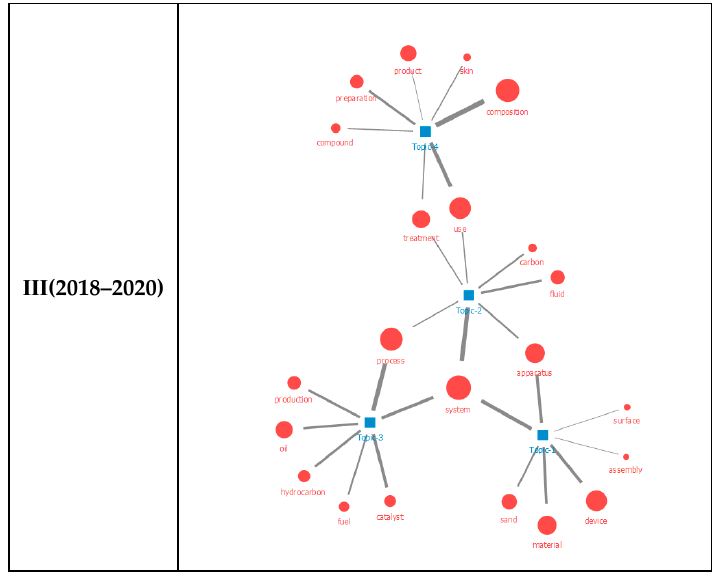
Figure 3. Result of topic modeling by time series.